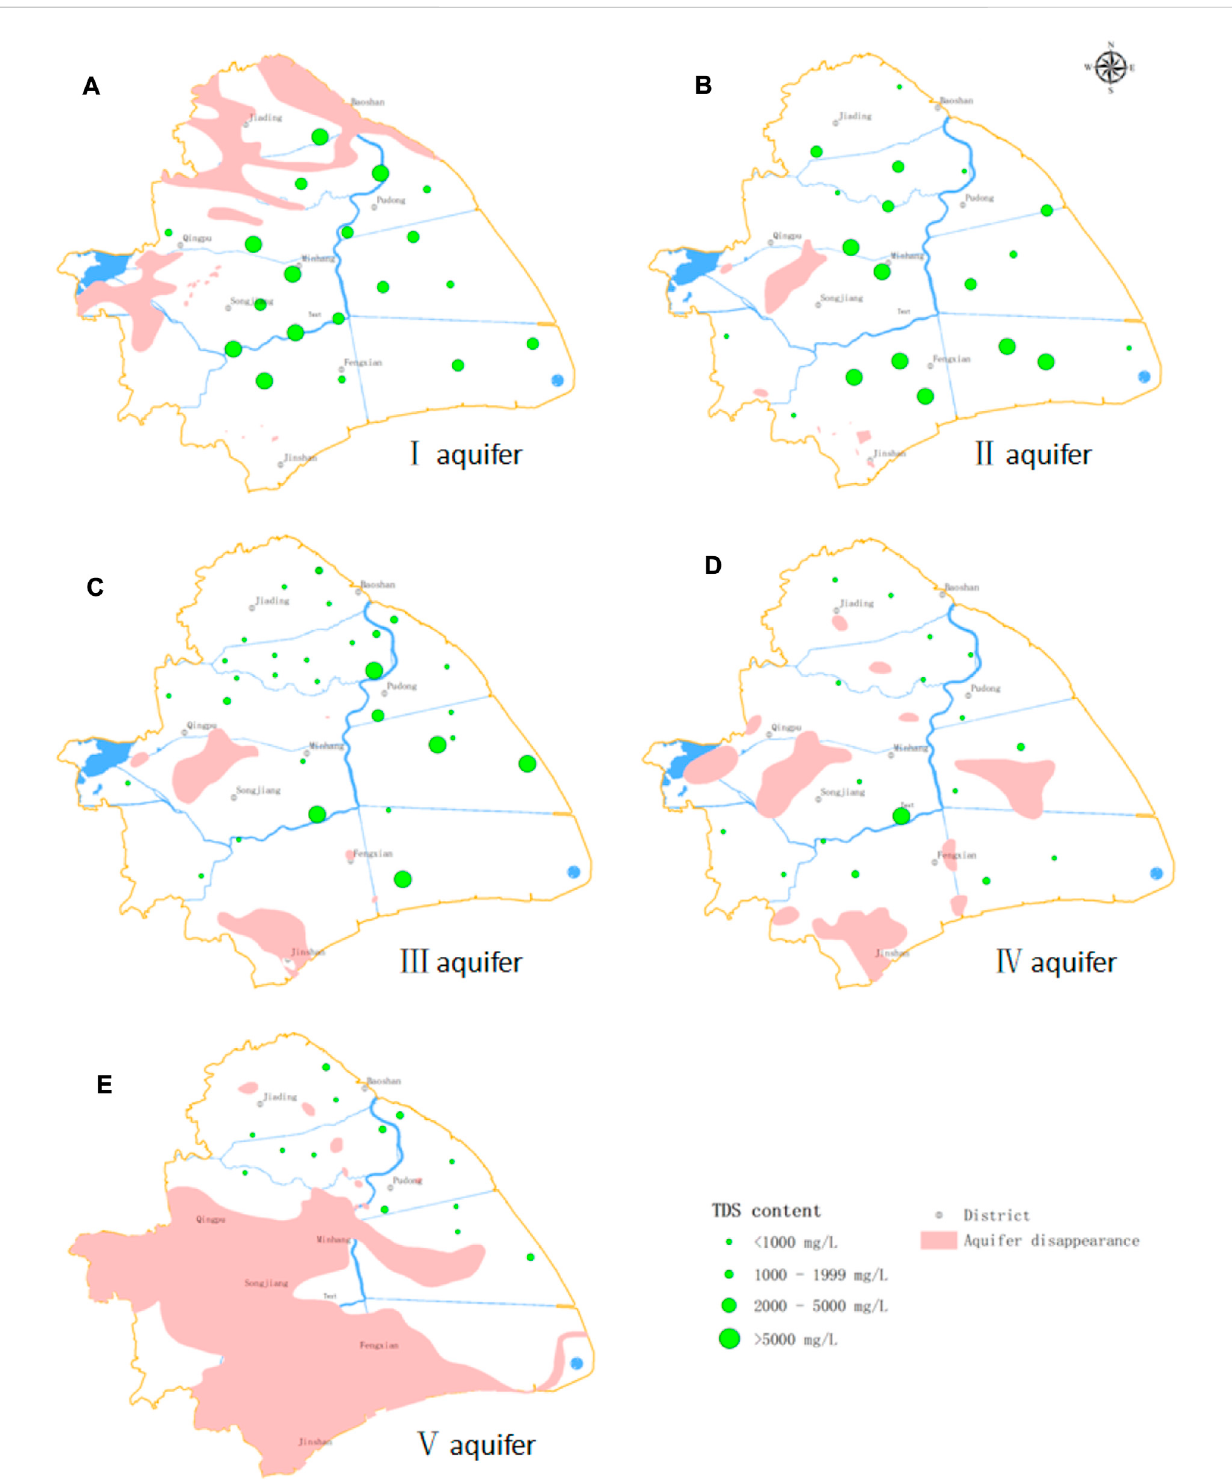
FIGURE 3 Spatial distribution of TDS in the study area. Dot sizes indicate TDS concentrations as follows: the larger the dot, the higher the TDS concentration. (A) TDSconcentrationsofallsamplesinaquiferIwere > 1000 mgL − 1 andgraduallyincreasefromeasttowest;salinewaterwasdistributedthroughoutthe aquifer. (B) InaquiferII,68.4%ofsampleshadTDSconcentrations > 1000 mgL − 1 ;salinewater occupiesmostoftheaquifer. (C) Inaquifer III,groundwater TDSconcentrationsweremarkedlyhigherintheeastthaninthewest.Additionally,salinewaterismainlydistributedintheeasternpartoftheaquifer, whereasfreshwaterismainlydistributedinthewesternpartoftheaquifer. (D) InaquiferIV,mostsampleshaveTDSconcentrations < 1000 mgL − 1 withthe exception of one sample from the area connecting aquifers III and IV that had TDS = 7010 mg L − 1 and another from the same area in aquifer III that